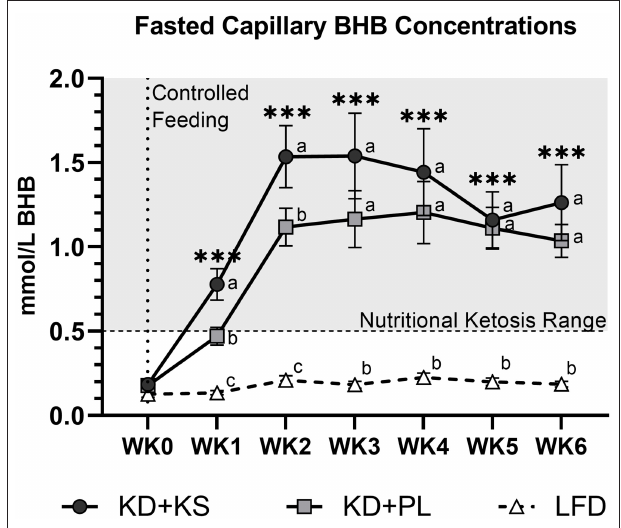
FIGURE 1 | Fasting capillary BHB responses to a ketogenic diet plus ketone salt (KD + KS) vs. placebo (KD + PL). Values at each week represent mean ( ± SEM) of 7-day BHB values. Primary Statistics: 2 (group) × 7 (time point) ANOVA followed by secondary 3 × 7 ANOVA that included a third low-fat